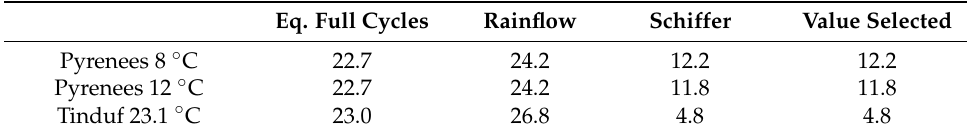
Figure 6. Hourly simulation of Tindouf—Li-ion battery: load (W) ( a ), PV generation (W) ( b ), battery bank discharge rate (% of Cn) ( c ), charge rate (% of Cn) ( d ) and SOC (%) ( e ). The estimated battery lifetimes obtained by the different models are shown in Table 4 (lead-acid) and Table 5 (Li-ion). Table 4. Results. Battery lifetime estimation (years) for lead-acid